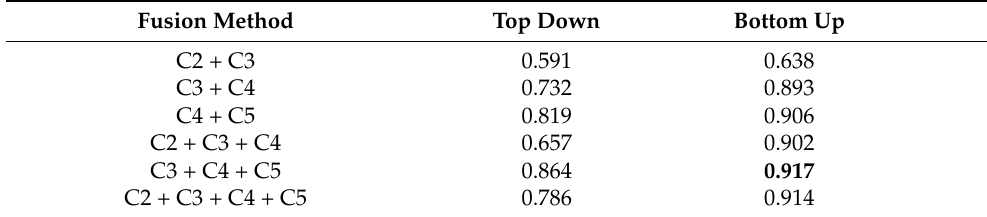
Table 6. Detection results of lager-scale ships with different fusion methods. Fusion